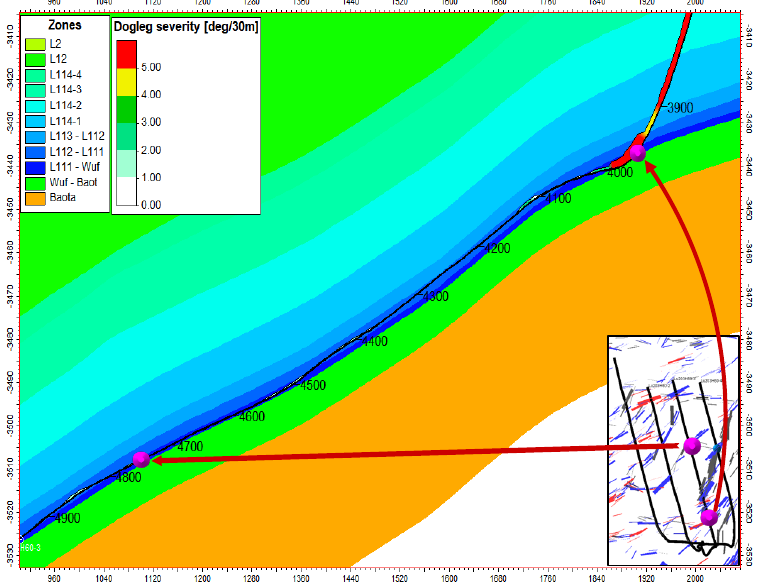
Figure 15. Comparison of casing deformation position, horizon and dogleg degree of well Lu 203H60-3.